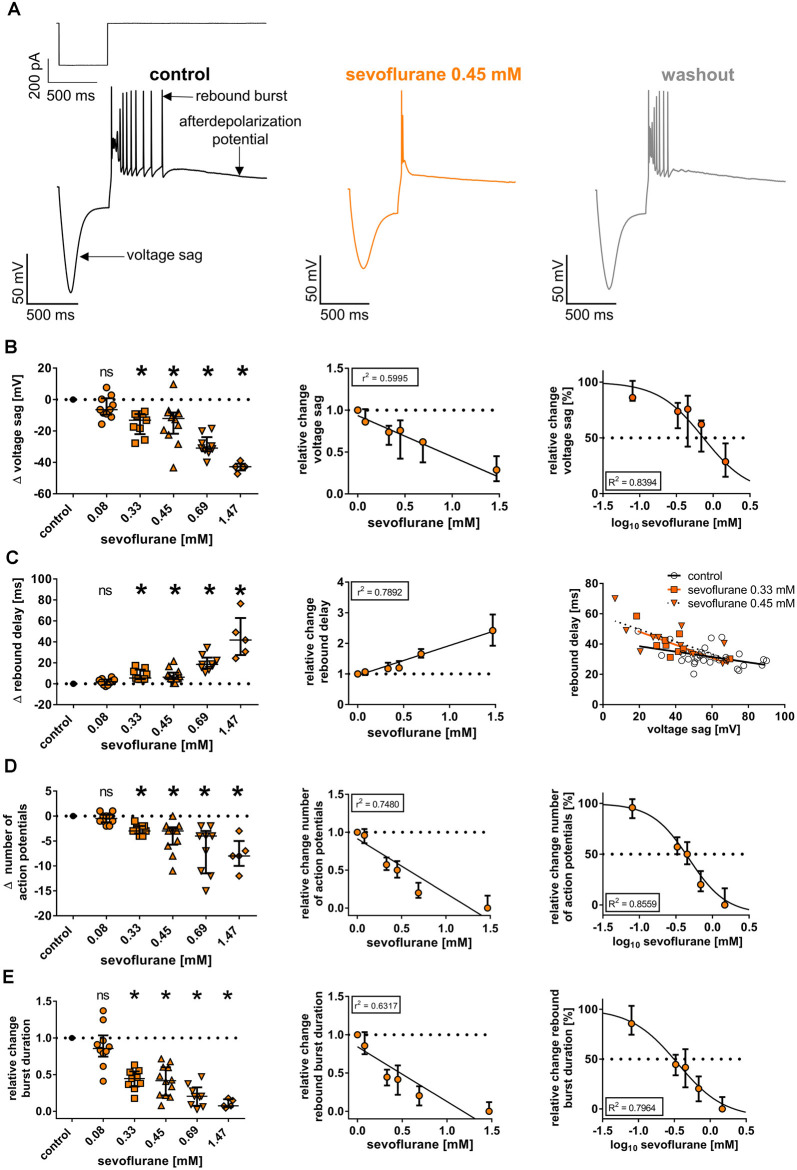
(A) Upon a hyperpolarizing current injection (−350 pA, 500 ms), thalamocortical relay neurons demonstrated a prominent, inwardly directed rectification of the membrane potential (voltage sag), followed by low-threshold calcium spike rebound burst firing (rebound burst) and an afterdepolarization potential. Exemplar membrane voltage traces under control conditions (with current protocol shown above), in the presence of 0.45 mM sevoflurane, and after a 20-min washout. (B) Beginning at a concentration of 0.33 mM, sevoflurane significantly impaired the voltage sag [control: 57.9 (49.9–73.3) mV, n = 45]. The reduction occurred in a concentration-dependent manner, using linear and non-linear regression analysis. Δ: absolute change compared to control. ns, not significant. *p < 0.05. (C) Conversely, sevoflurane significantly prolonged the rebound burst delay [control: 30.0 (26.9–33.6) ms, n = 45] starting from a concentration of 0.33 mM in a dose-dependent fashion. On the right, voltage sag amplitudes are plotted as a function of rebound delay under control conditions and in the presence of 0.33 mM and 0.45 mM sevoflurane with corresponding regression lines. Following previous findings, correlation analysis revealed an inverse correlation between voltage sag amplitude and rebound burst delay, which was intensified with increasing sevoflurane concentrations. (D) Further, sevoflurane significantly decreased the number of action potentials seen during rebound burst spiking [control: 7.0 (5.0–8.5) mV, n = 45] beginning at a concentration of 0.33 mM and the reduction was mediated in a concentration-dependent manner. (E) Lastly, sevoflurane significantly abbreviated burst duration [control: 74.0 (57.0–122.3) ms, n = 45] starting at a concentration of 0.33 mM in a dose-dependent fashion.